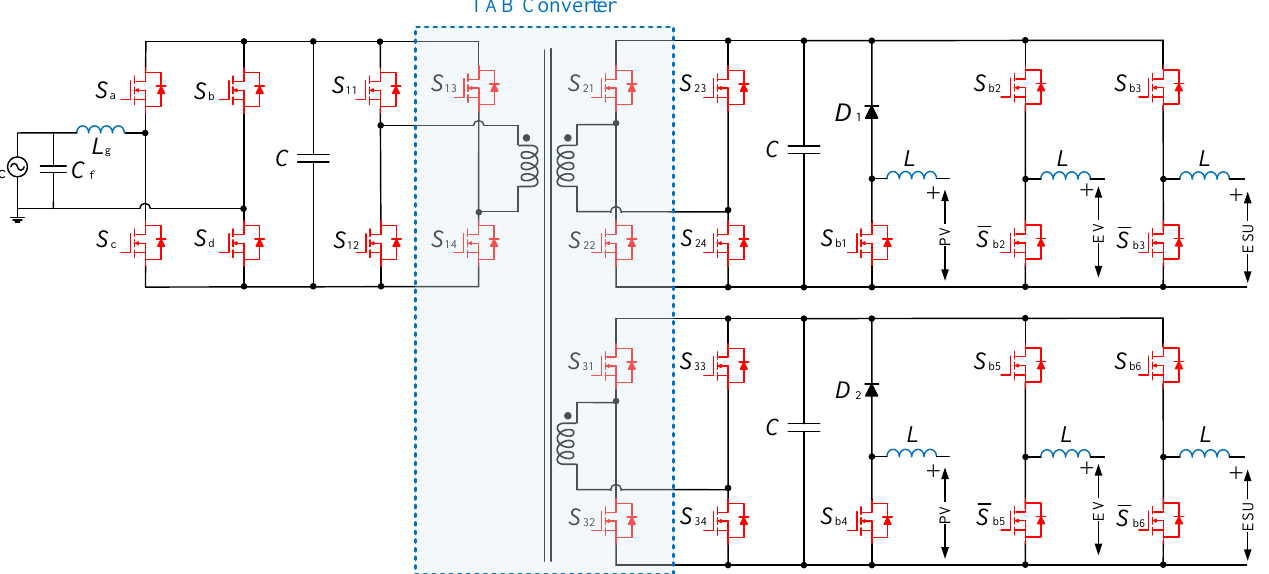
Figure 13. Three-port integrated architecture for EV charging, including a unidirectional DC – DC interleaved boost topology for the PV port, a bidirectional three-phase VSI for the grid port, and a bidirectional isolated interleaved DC – DC Flyback topology for EV side [18].